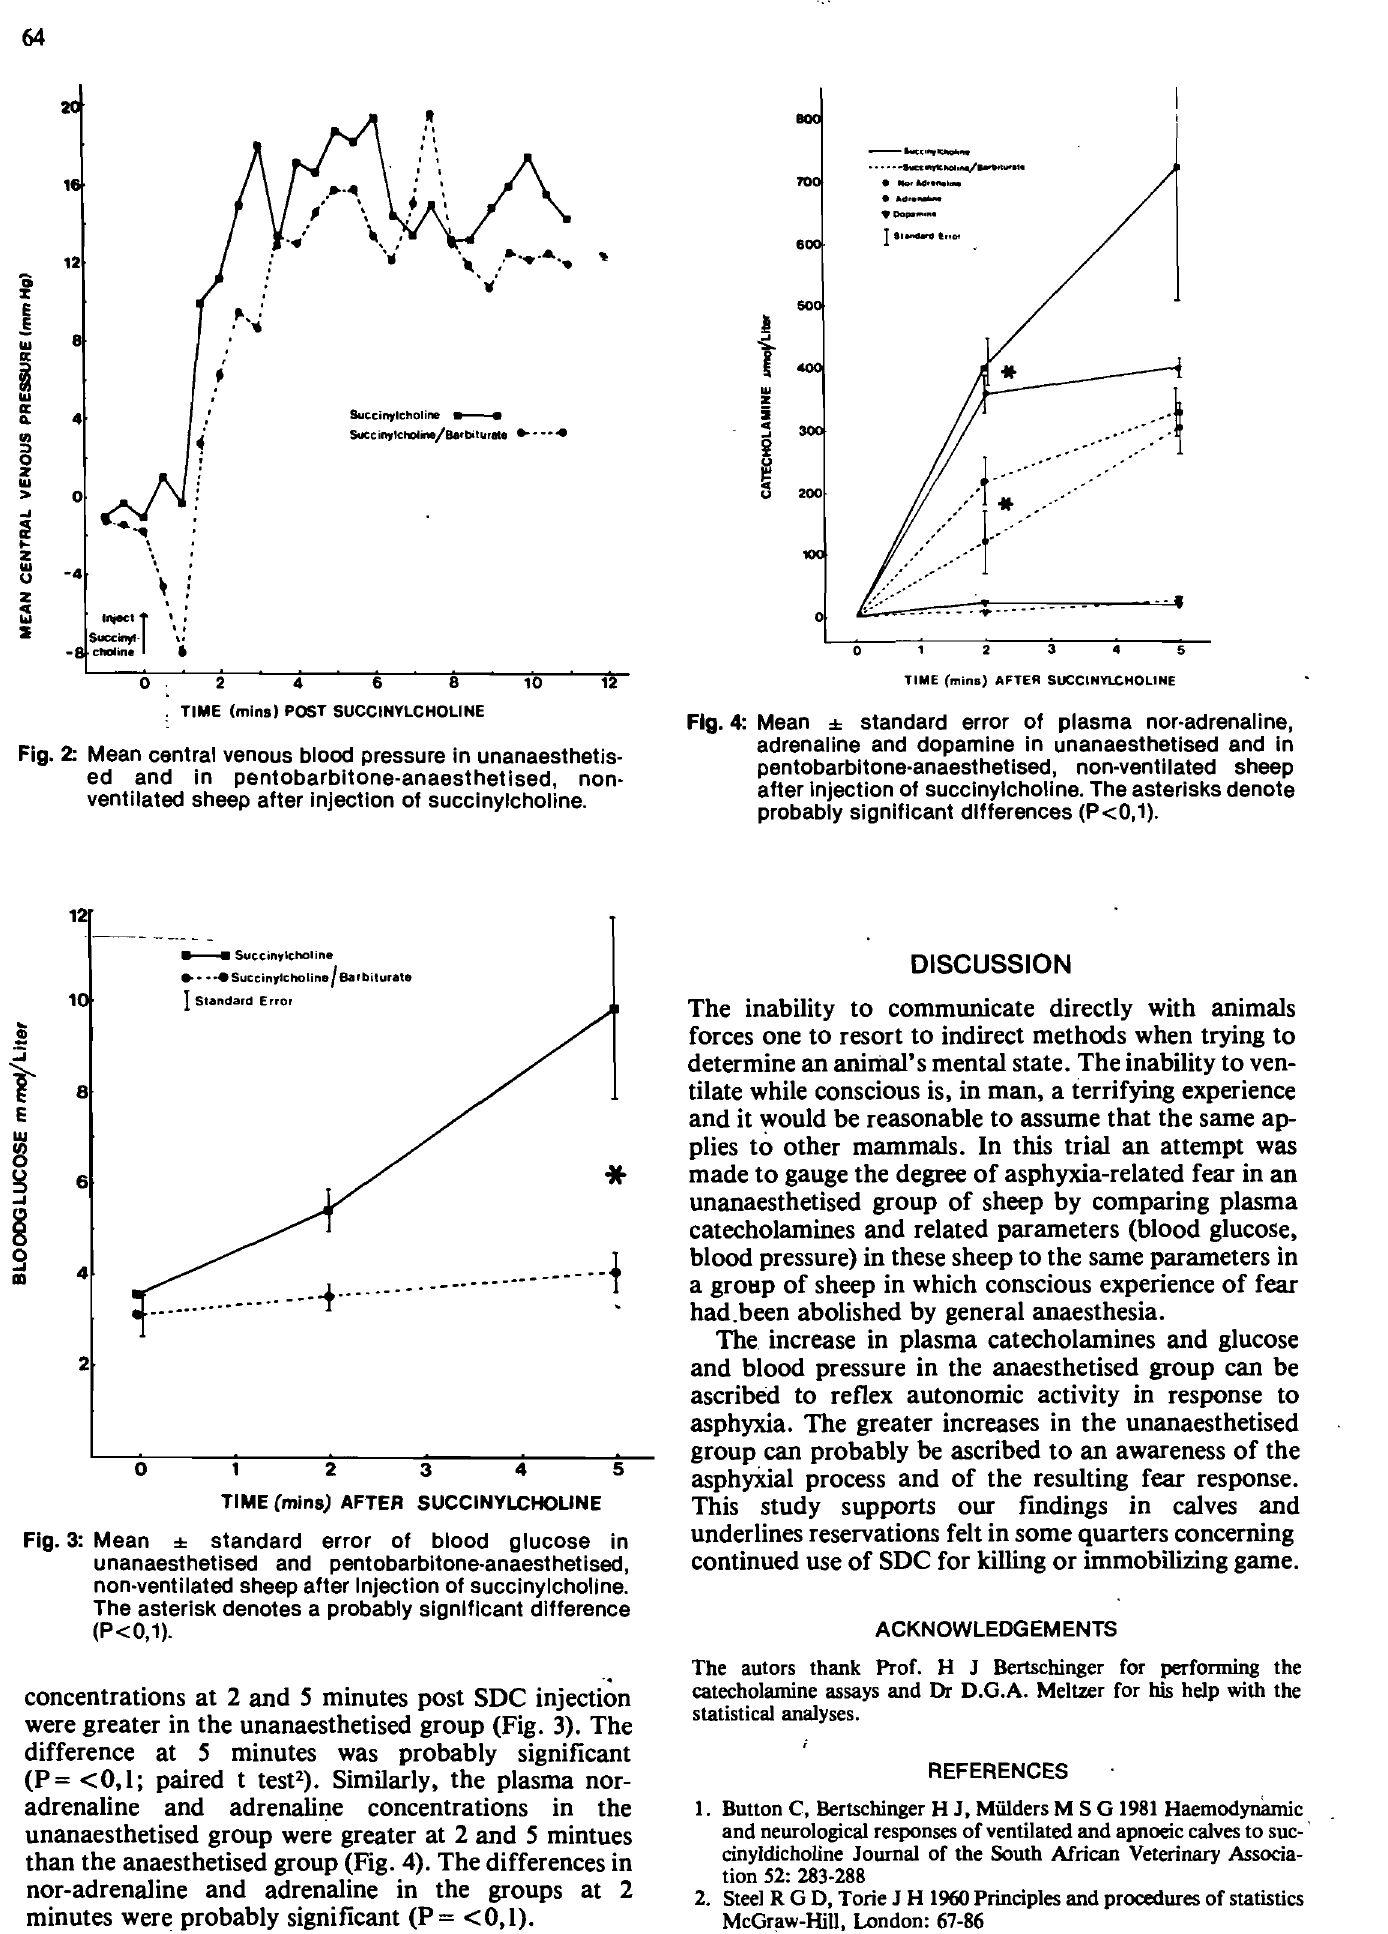
Fig. 2: Mean central venous blood pressure in unanaesthetis ed and in pentobarbitone-anaesthetised, non ventilated sheep after injection of succinylcholine.